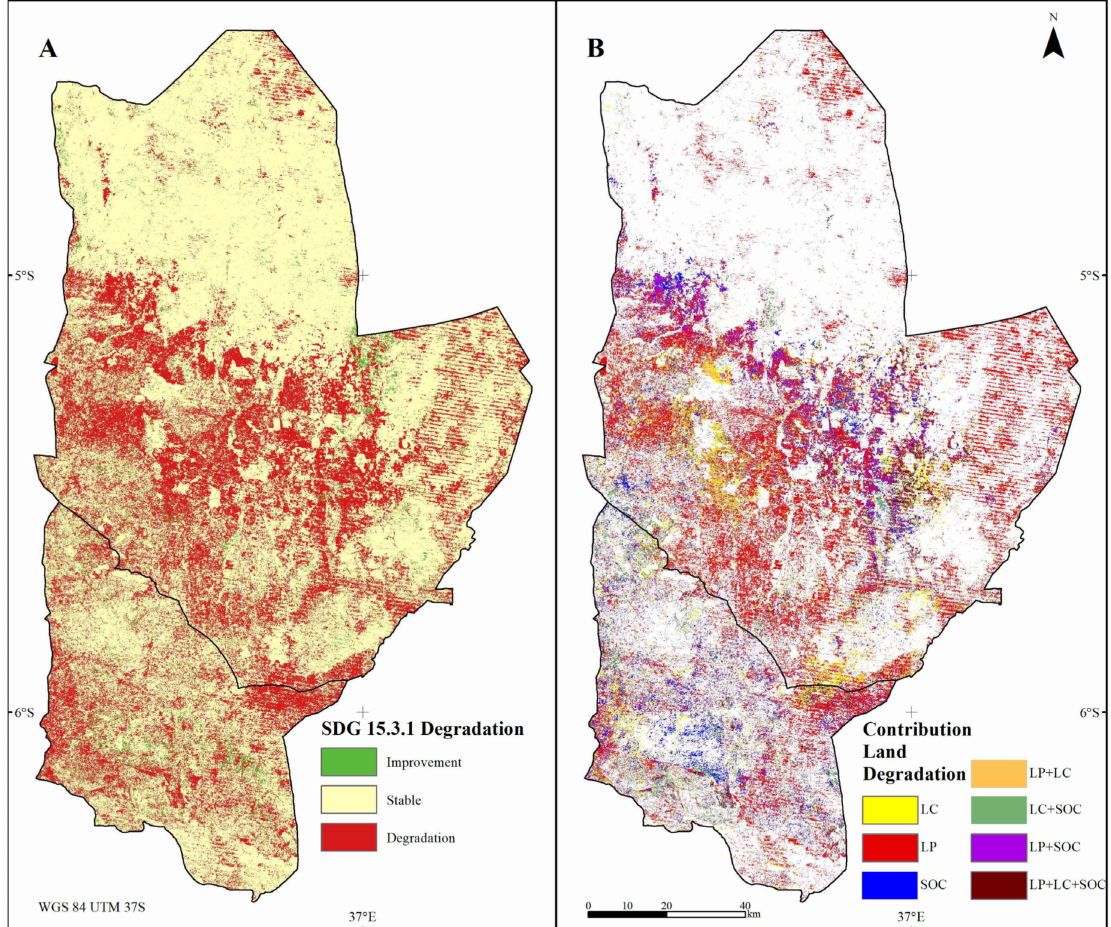
Figure 8. ( A ) The sustainable development goal (SDG) 15.3.1 indicator “proportion of land that is degraded over total land area” for the years 2000–2019 and ( B ) the contribution to the SDG 15.3.1 indicator by its three sub-indicators land cover (LC) change, land productivity (LP) decline and soil organic carbon (SOC)